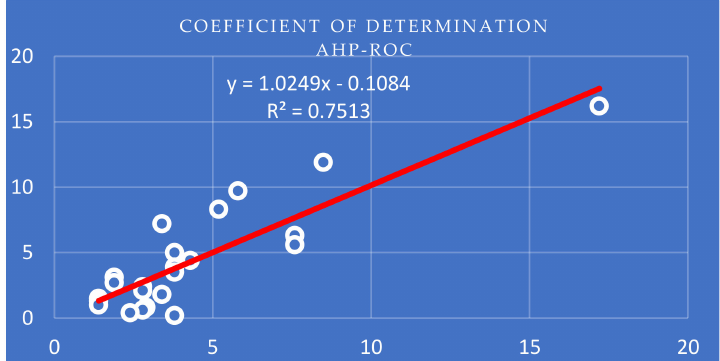
Figure 13. AHP-ROC Coe ffi cient of